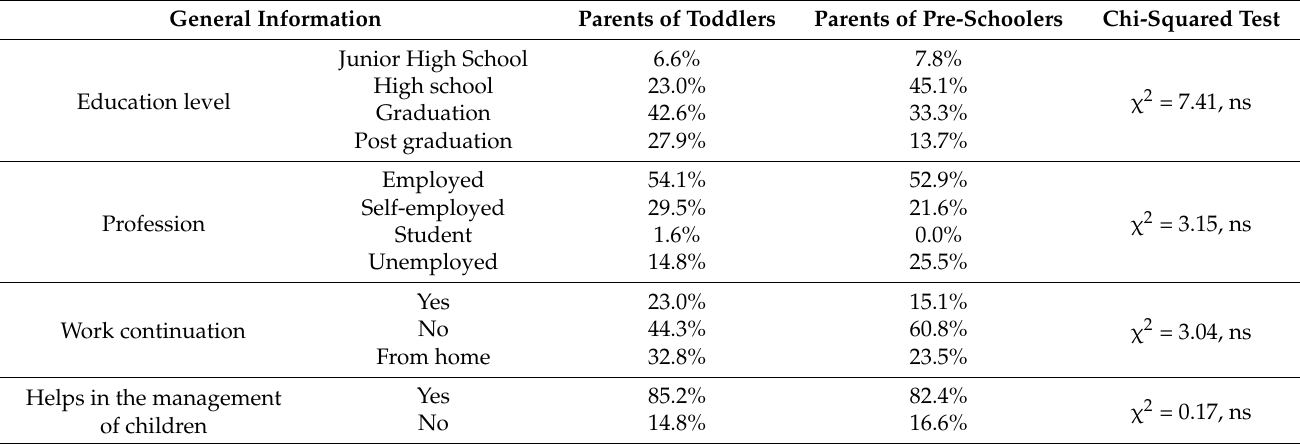
Table 2. Statistics of respondents related to general information and COVID-19 items. All values are expressed in %. General